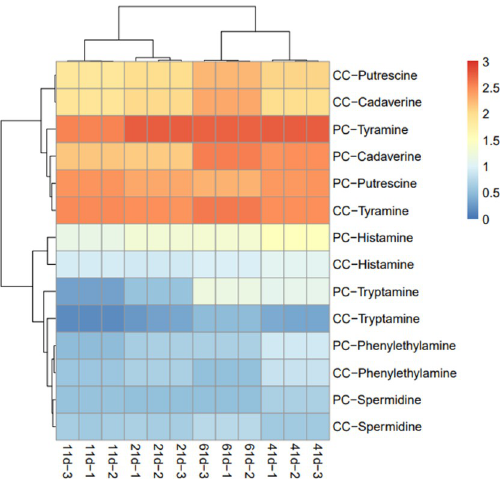
Fig 1. Biogenic amine content heatmap analysis for fermented sausages during storage. Each column in heat map represented a different point in time. The ordinate was the relative abundance of each group. The closer the color is to red, the higher the relative abundance of corresponding biogenic amines, and the closer the color is to blue, the lower the relative abundance of corresponding biogenic amines.